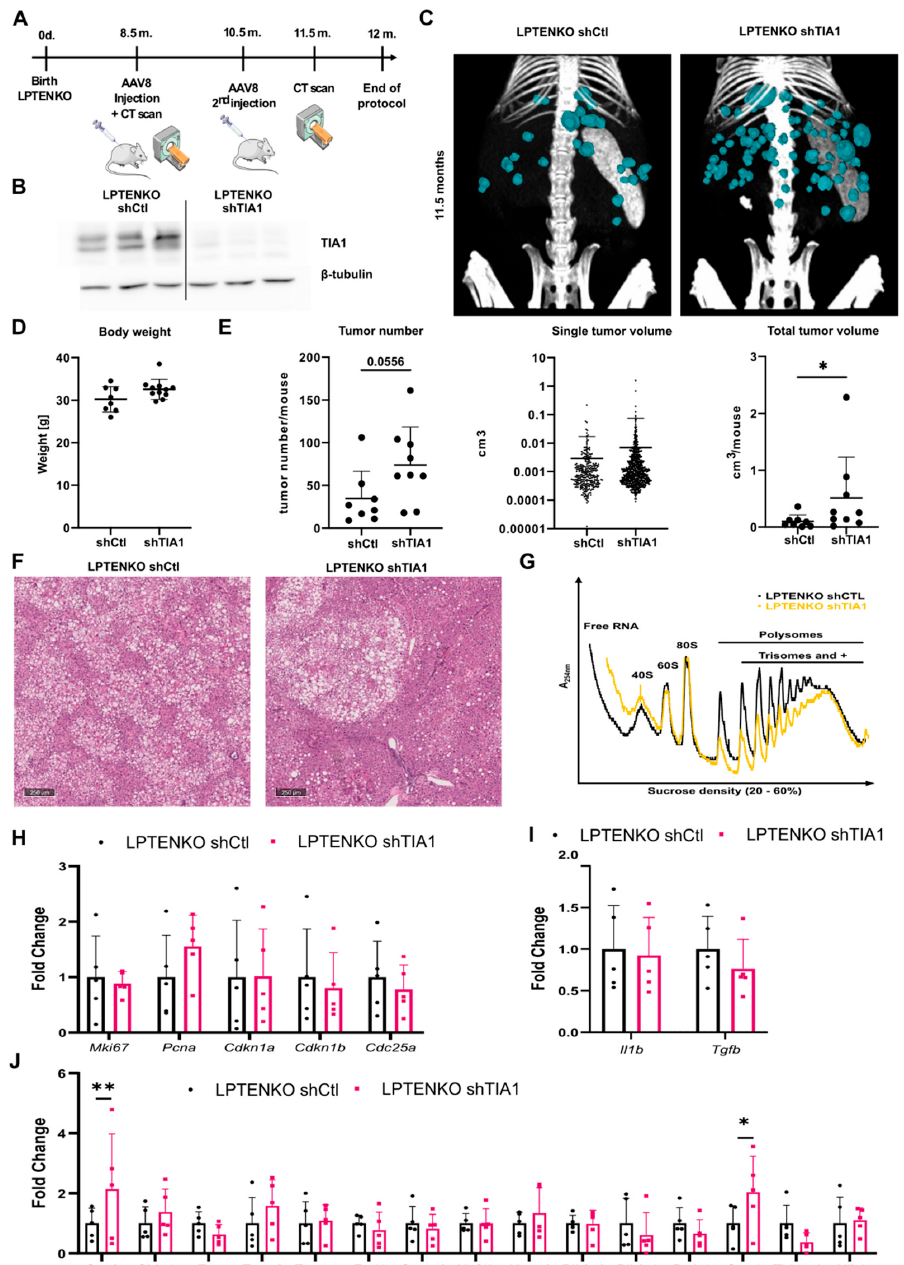
Figure 4. TIA1 loss promotes hepatic tumor burden in vivo. ( A ) Protocol of TIA1 silencing in LPTENKO mice. ( B ) TIA1 protein expression in livers of 11.5 m old LPTENKO mice injected with AAV8 virus against TIA1 and a scramble control (shCtl), normalized by β -tubulin. Original blots see File S2. ( C ) Representative 3D reconstructions of computed tomography scans of LPTENKO livers ± shTIA1 at 11.5 months. ( D ) Body weight of LPTENKO mice ± shTIA1 (n = 8 and 11, respectively). ( E ) Tumor number and tumoral volumes in livers of LPTENKO mice ± shTIA1 (n = 8 and 9, respectively). ( F ) Representative pictures of livers of LPTENKO mice ± shTIA1 stained with hematoxylin and eosin. ( G ) Representative polysome profiles of livers of LPTENKO mice ± shTIA1. ( H , I ) Relative mRNA expression of ( H ) proliferation and ( I ) inflammatory markers for potential TIA1 targets ( J ) in highly translated fractions of livers of LPTENKO mice ± shTIA1 (n = 5). Data were represented as mean ± SD. Unpaired t-test was used for comparison of two groups. * p < 0.05, ** p < 0.01.